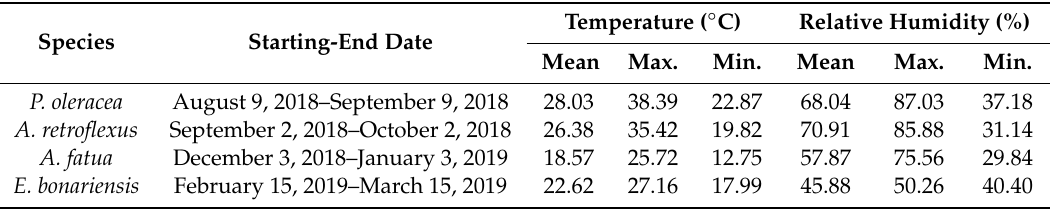
Table 3. Greenhouse conditions during the herbicidal